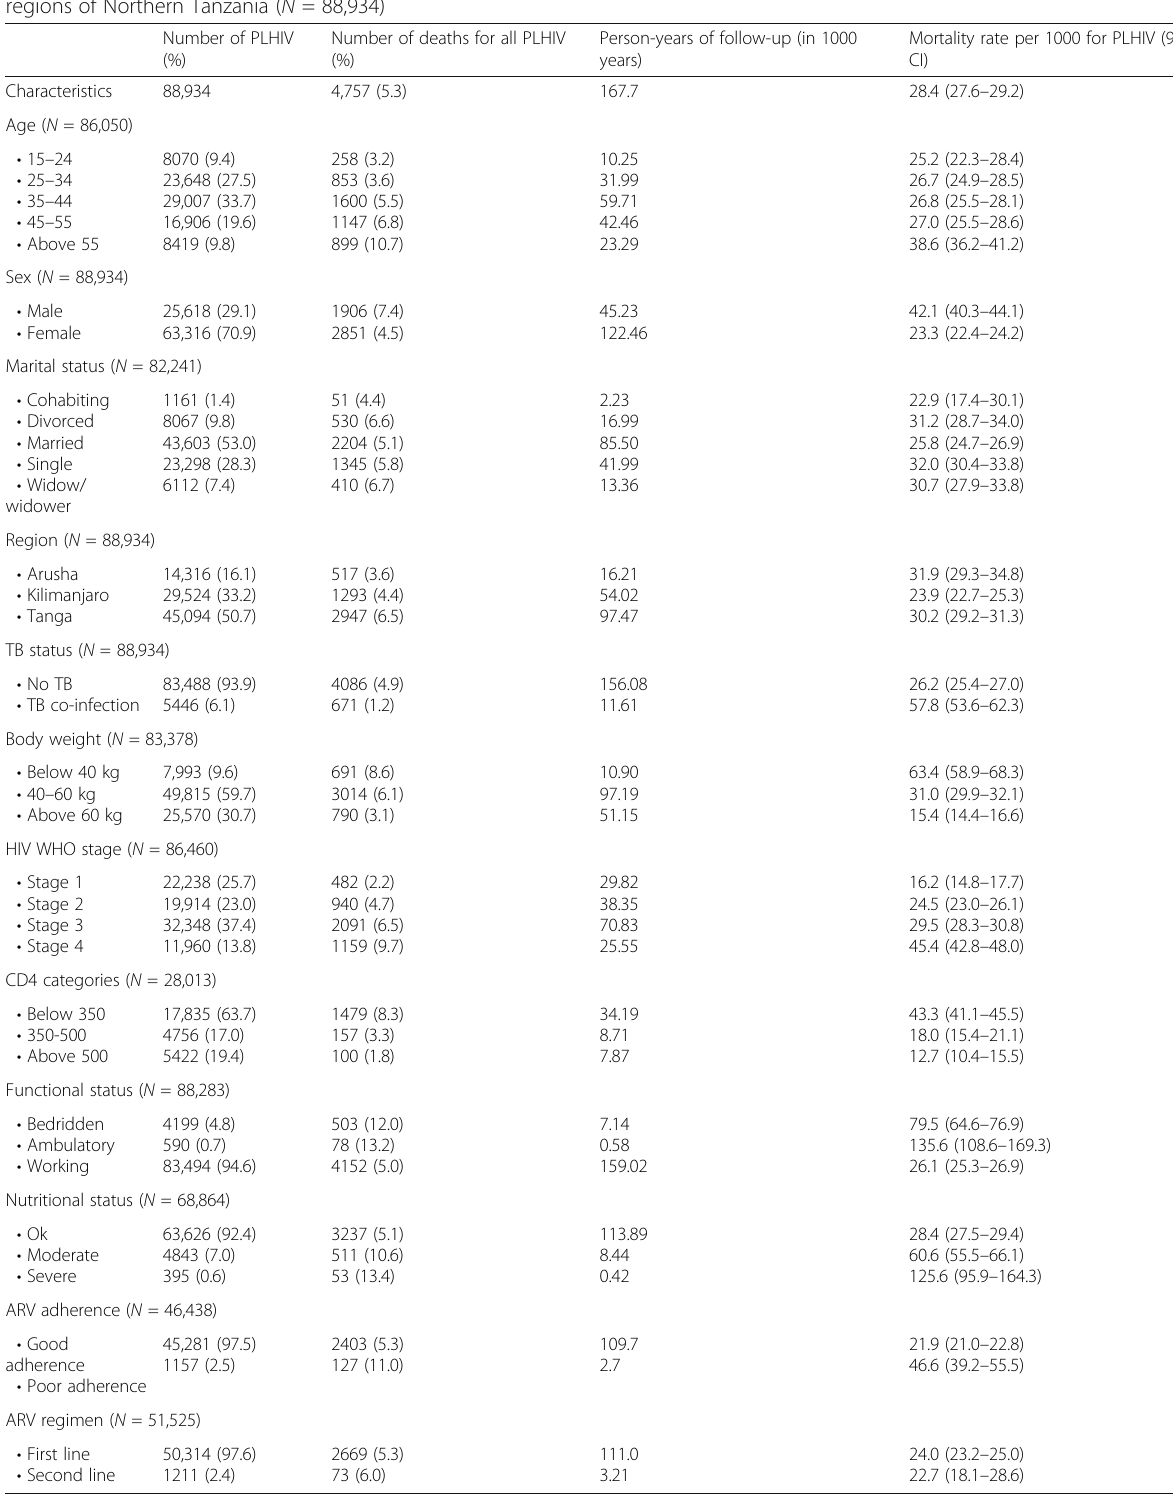
Table 1 Mortality rates by sociodemographic and clinical characteristics at enrolment into HIV services for PLHIV patients in three regions of Northern Tanzania ( N = 88,934) Number of PLHIV Number of deaths for all PLHIV (%) (%)